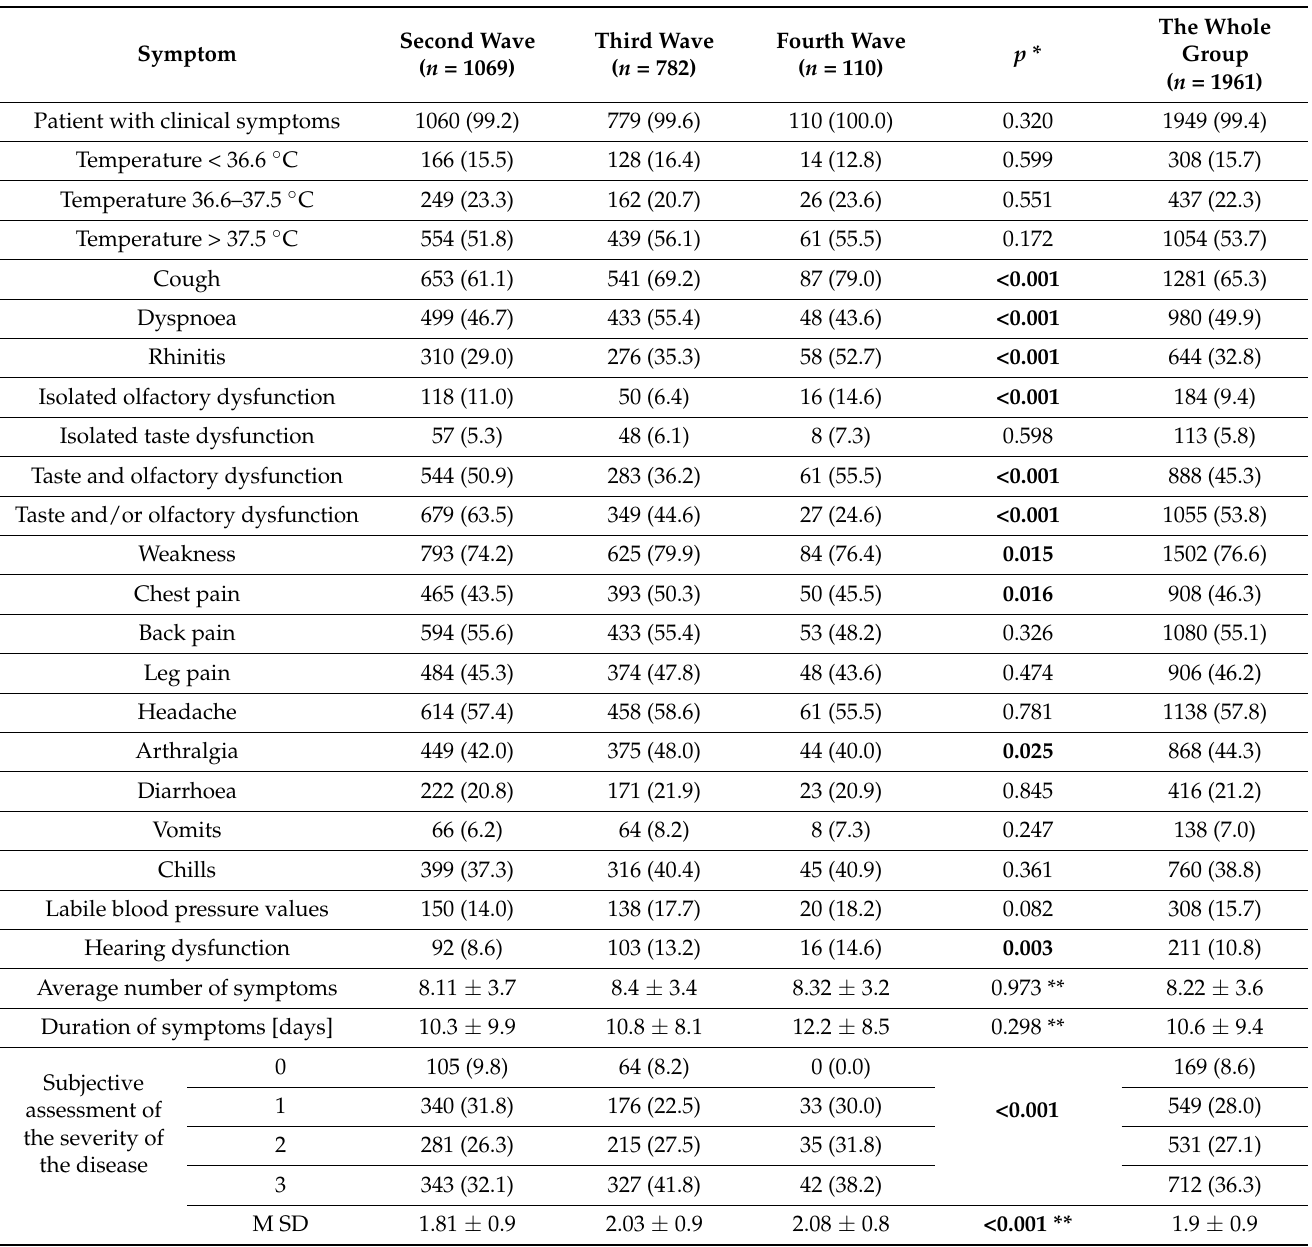
Table 2. Clinical manifestation of COVID-19 in the entire population and in successive waves of the